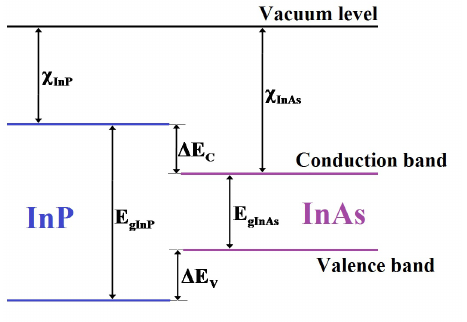
Fig. 1. InP/InAs zone diogram